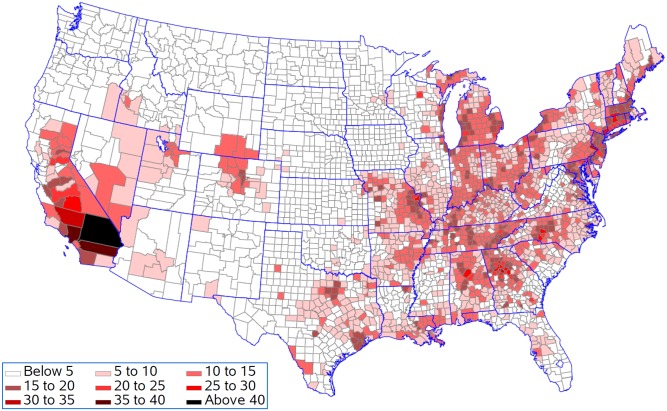
Increase in death from cardiovascular diseases (per 100,000 population per year) resulting from being above the regional 25th percentile for each pollutant.